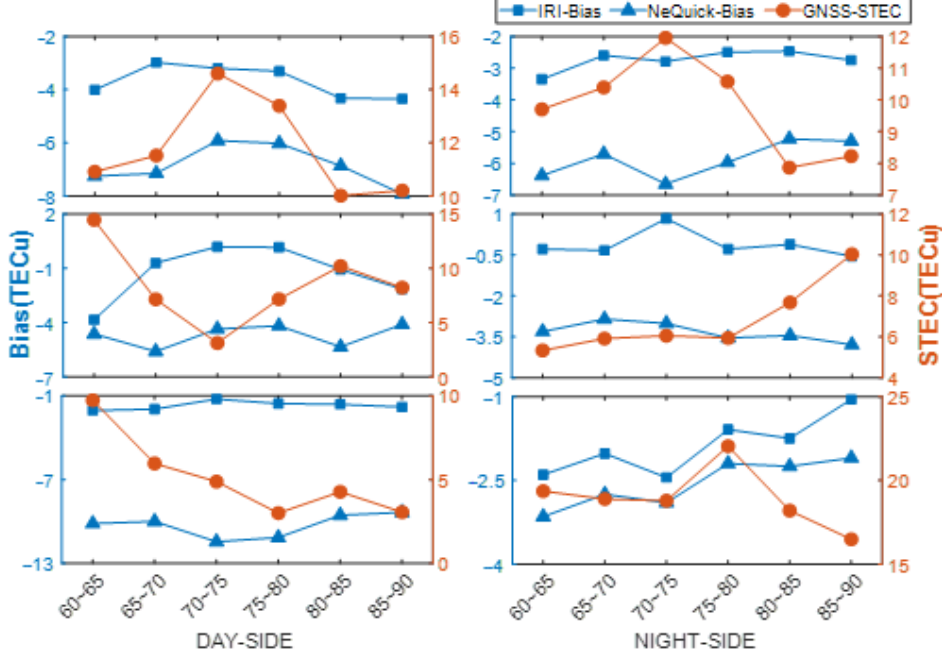
Figure 8. Variation in GNSS STEC and modeling bias values. Three rows are aligned vertically at both left- and right-hand sides, respectively. The left-hand side represents the statistics of the variation of GNSS STEC and bias of two models with latitude in day side, while right-hand side represents in night side. The first row represents GNSS STEC and bias variation of two models from 1:00 to 3:00 in March and September. The second row represents STEC and bias variation of two models from 13:00 to 15:00 in March and September. The third row represents STEC and bias variation of two models in June and December. Day side means polar day and night side means polar night.